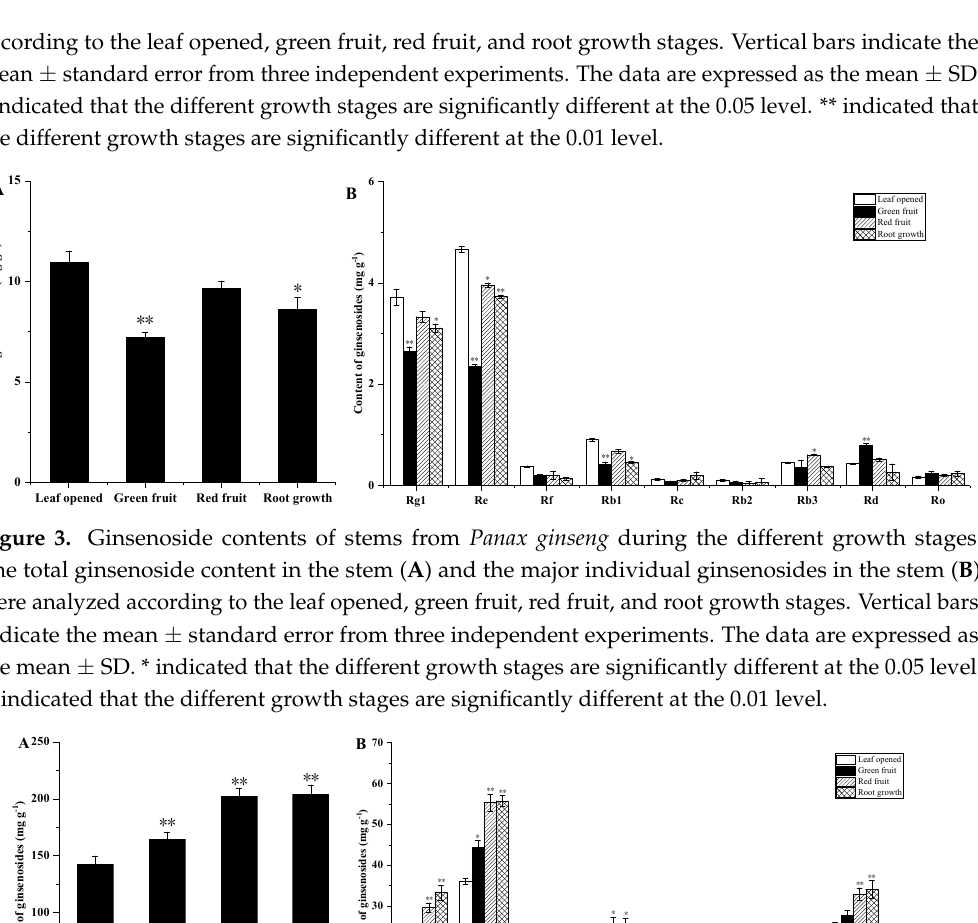
Figure 4. Ginsenoside contents of leaves from Panax ginseng during the different growth stages. The total ginsenoside content in the leaf ( A ) and the major individual ginsenosides in the leaf ( B ) were analyzed according to the leaf opened, green fruit, red fruit, and root growth stages. Vertical bars indicate the mean ± standard error from three independent experiments. The data are expressed as the mean ± SD. * indicated that the different growth stages are significantly different at the 0.05 level. ** indicated that the different growth stages are significantly different at the 0.01 level.